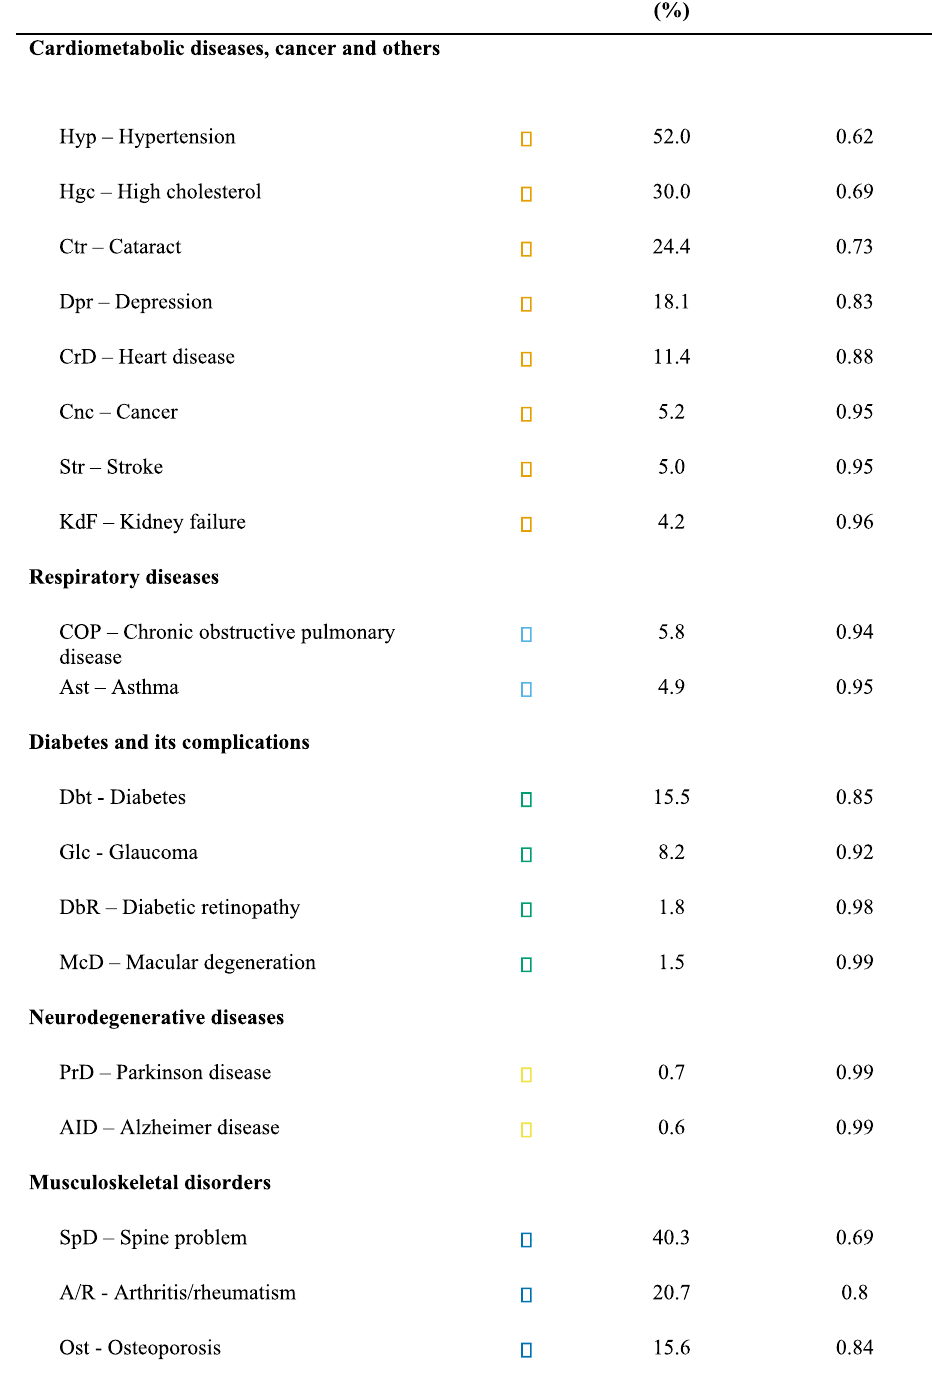
Table 3. Prevalence and centrality measure of hospitalisation network nodes, readmission and length of stay. The Brazilian Longitudinal Study of Ageing (ELSI-Brazil),